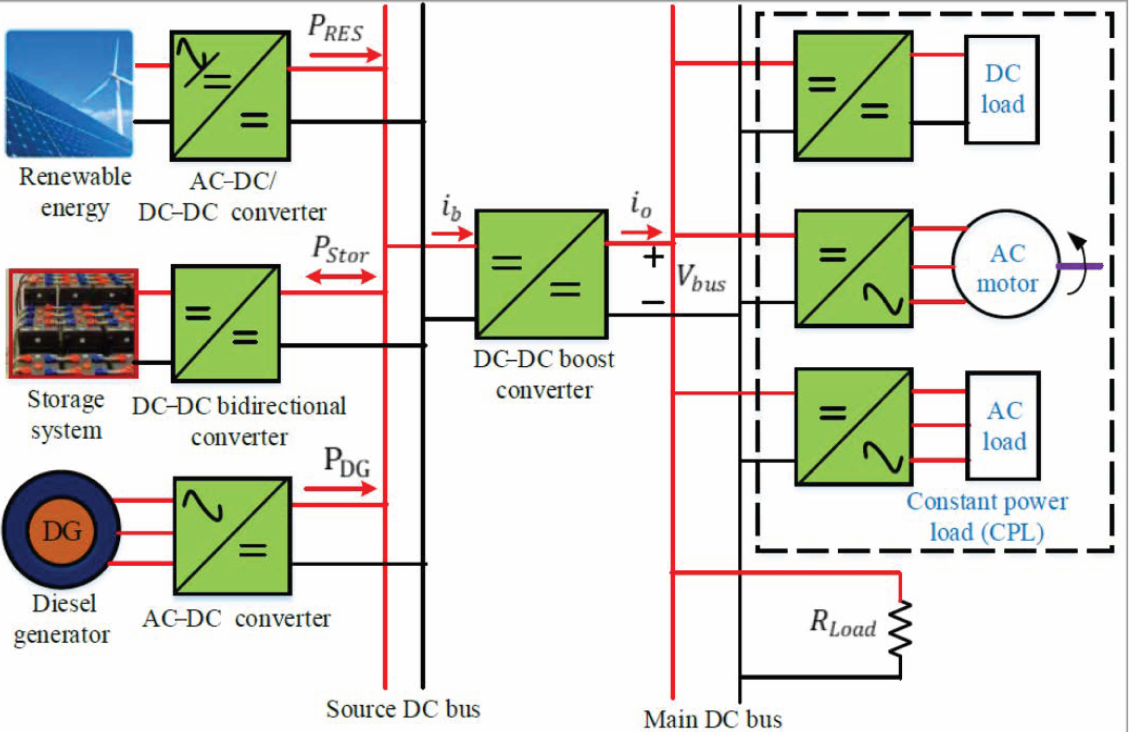
Figure 1. Typical layout of a